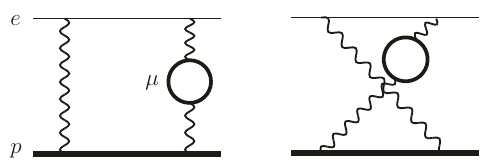
Figure 2 . Contribution to K pe due to muon vacuum polarization